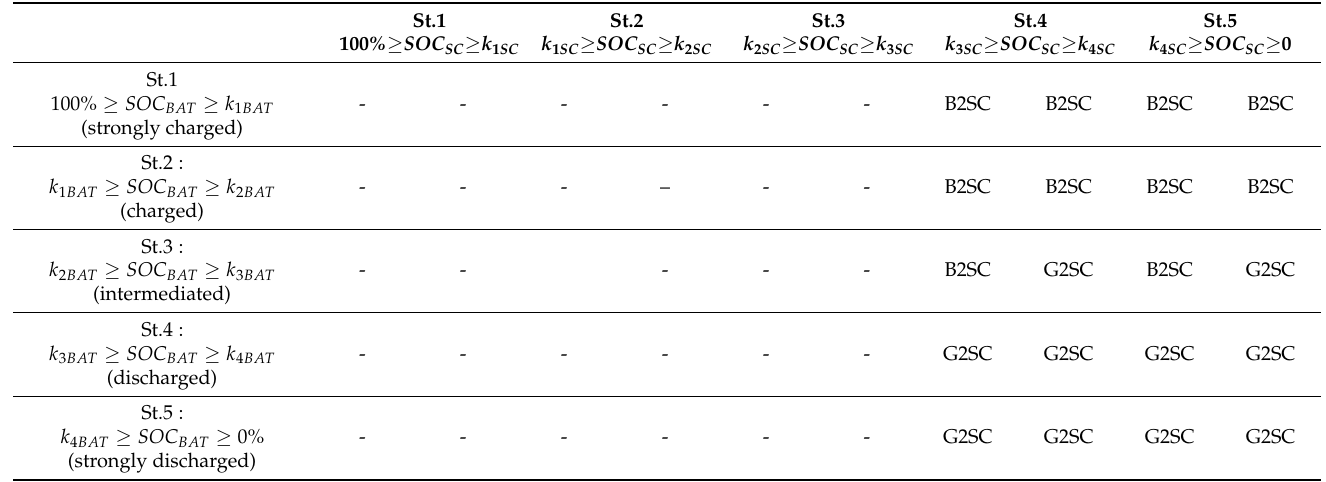
Table 4. EMS control rules for